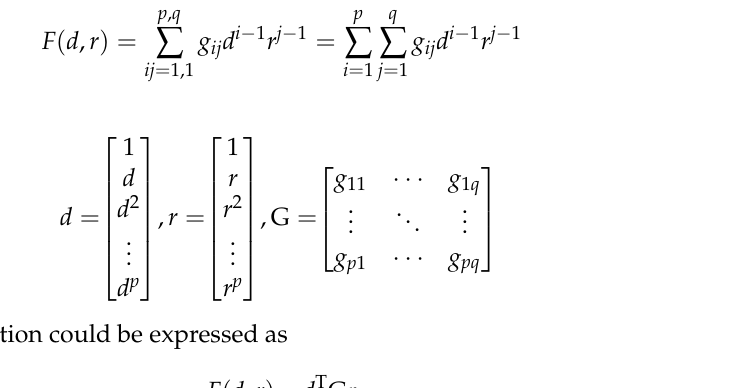
Figure 8. Schematic diagram of defect location. (A, B, C represent different areas of the apple. (a) is a diagram of the top view of the apple and (b) is a diagram of the front view of the apple).